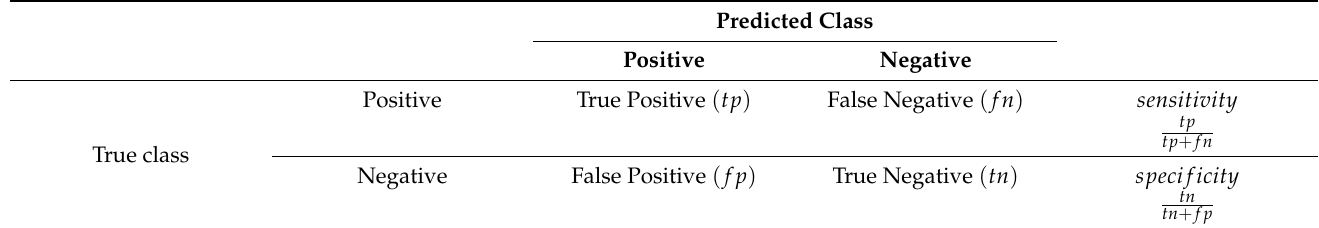
Table 1. Confusion matrix for binary